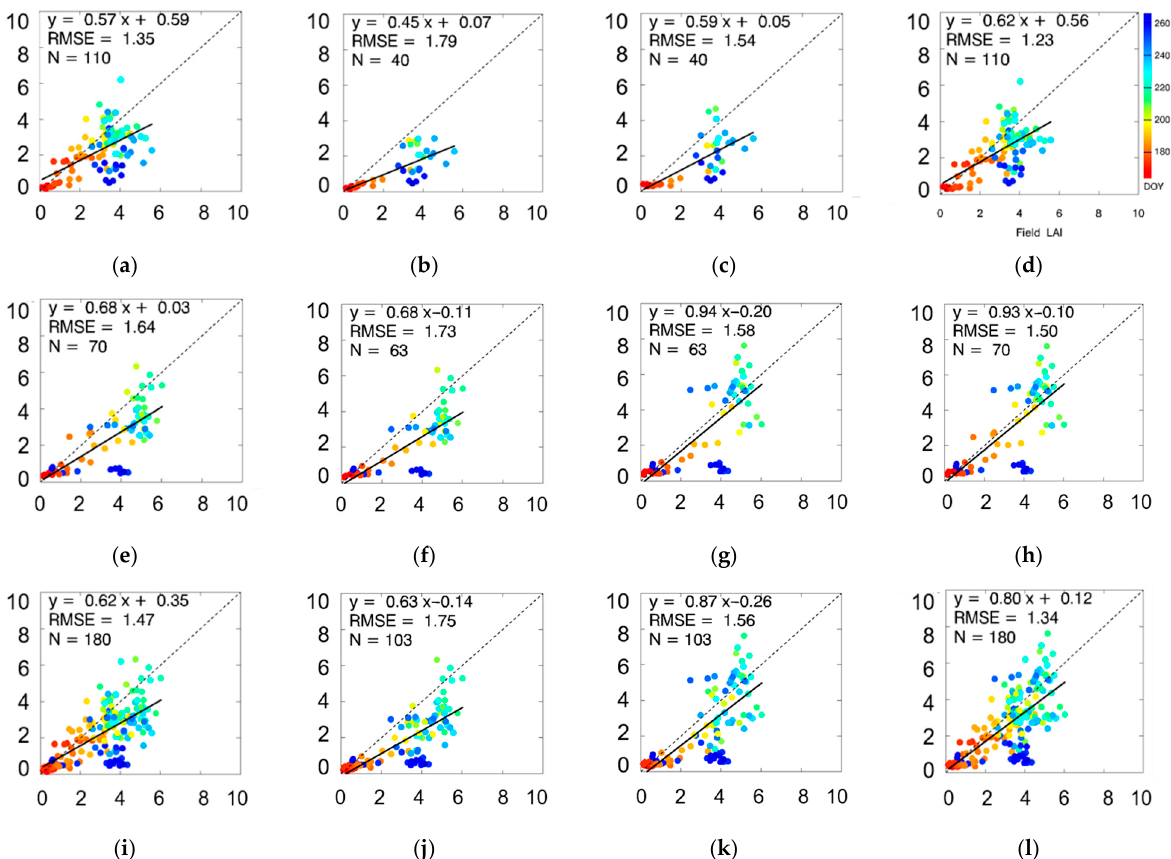
Figure 5. Comparison of the estimated LAI values to the field-measured data for paddy rice in Honghe ( a – d ), for maize, soybean, and sorghum in Hailun ( e – h ), and for all crops ( i – l ). The colors indicate the different observation dates. The estimated LAIs in the four columns from left to right are obtained based on the wide search method, the wide search method using local search data, the local search method, and the fused results from the wide and local search methods. Table 4. Estimation accuracy of the LAI for pixel-to-plot comparison.